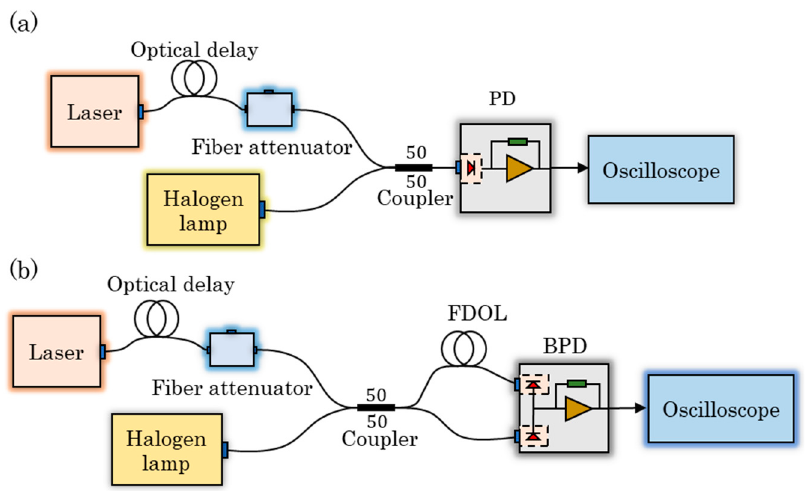
Figure 6. The experimental setup to measure the laser signal: ( a ) based on BDM and ( b ) based on SPM.